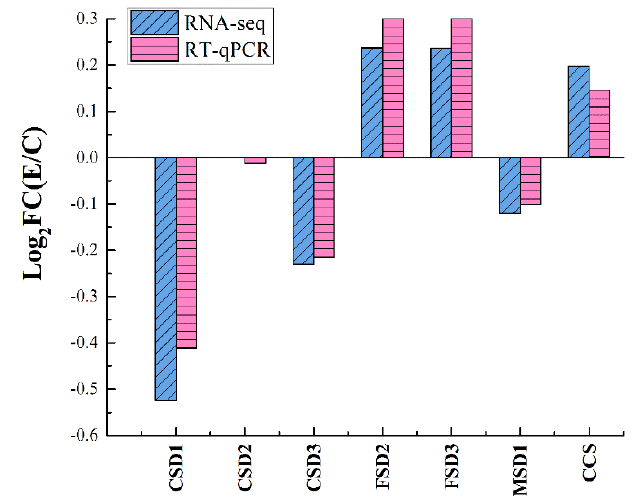
Figure 7. RNA-seq and RT-qPCR determination of 7 SOD genes of H. undatus peel at 168 h of storage.